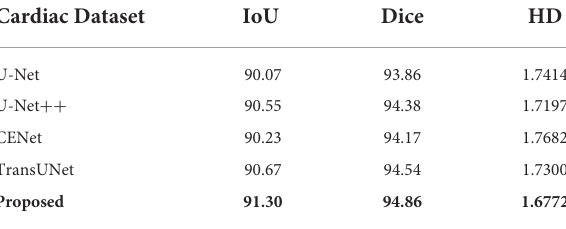
TABLE 2 Comparison of segmentation metrics on medical segmentation decathlon. Cardiac